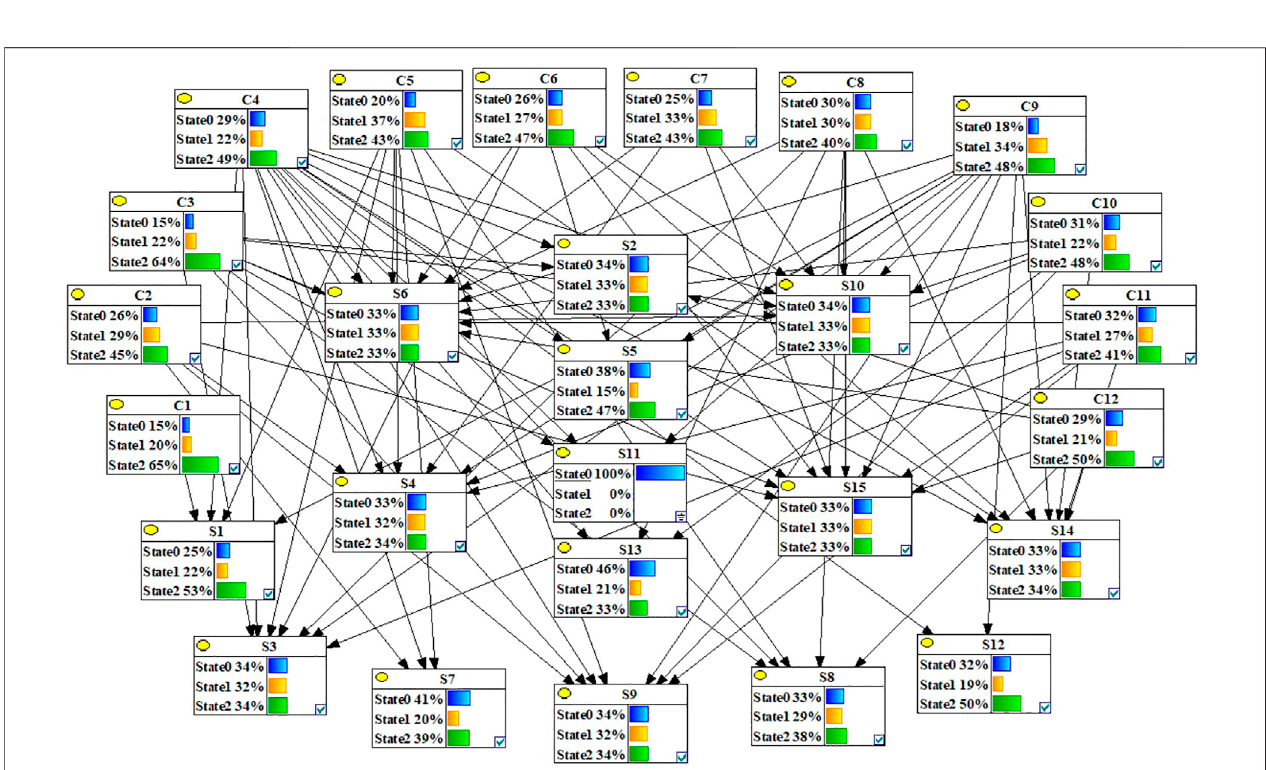
FIGURE 5 | Diagnostic analysis results of the case study.